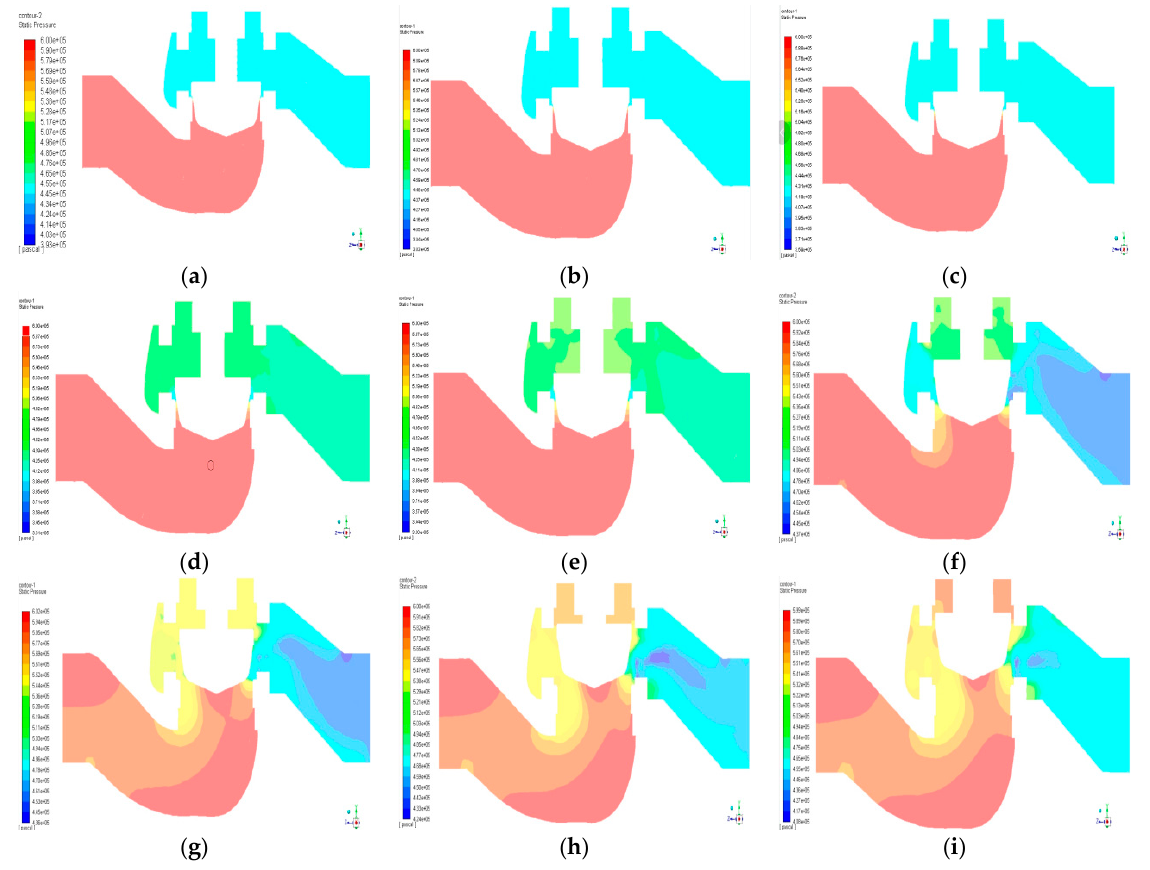
Figure 8. Contour maps of pressure distribution on the symmetrical surface at various valve openings: ( a ) 1%; ( b ) 2%; ( c ) 5%; ( d ) 10%; ( e ) 15%; ( f ) 40%; ( g ) 60%; ( h ) 80%; ( i ) 100%.